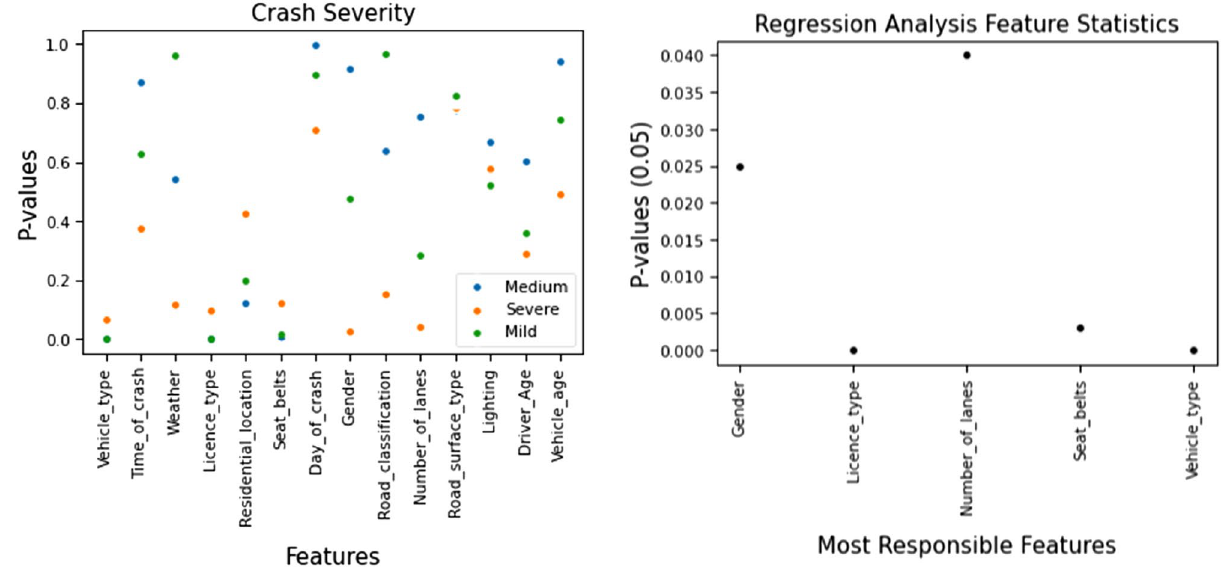
Figure 6. Regression analysis feature statistics to identify the most responsible features.